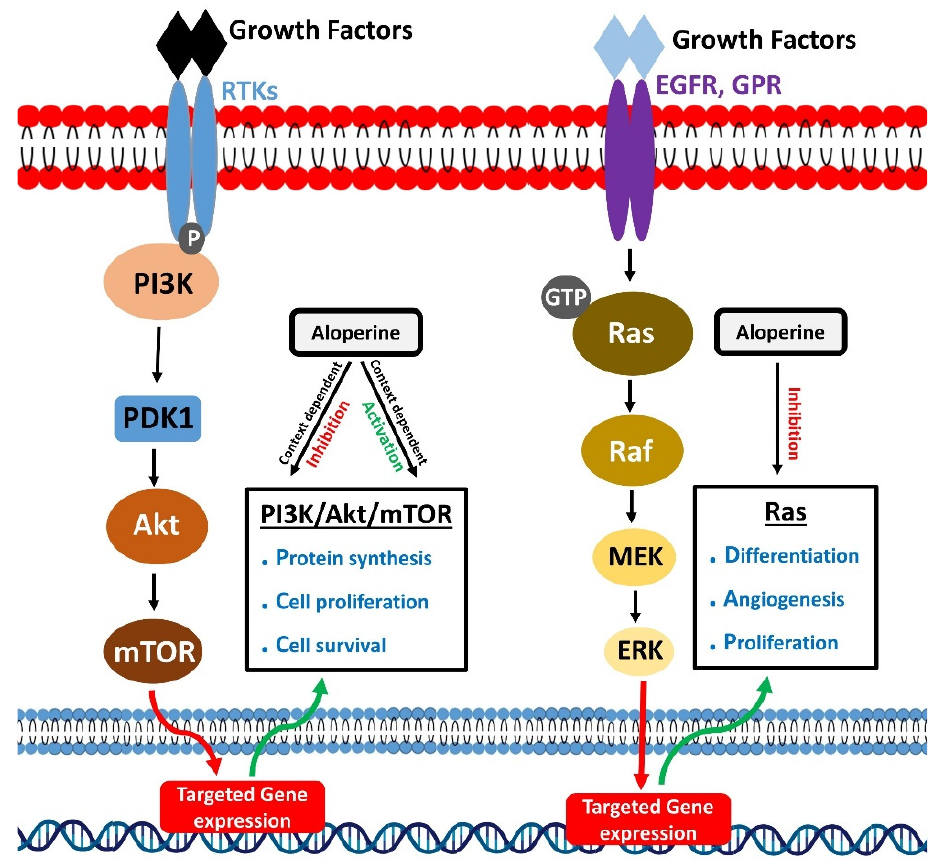
Figure 3. Modulatory effects of aloperine on PI3K/Akt/mTOR and Ras signaling.